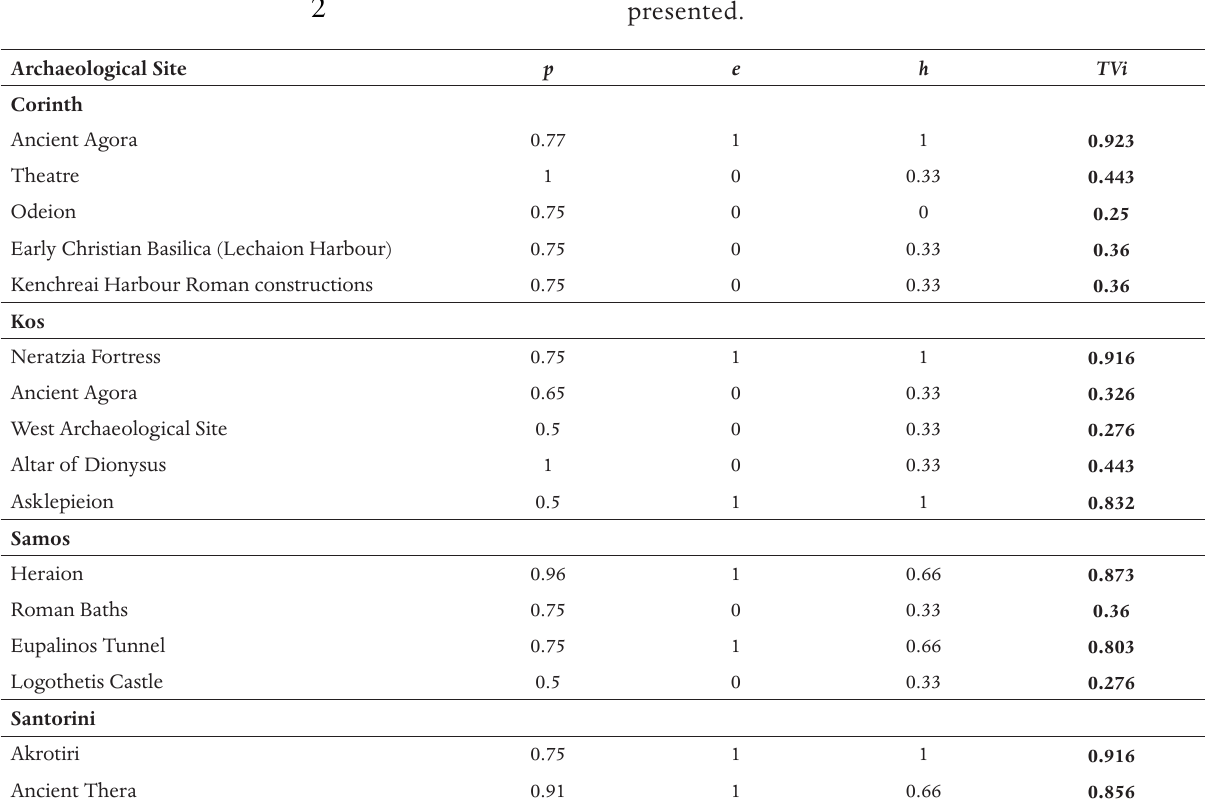
Table 5. Temporal vulnerability indicators and index for the archaeological sites under study.